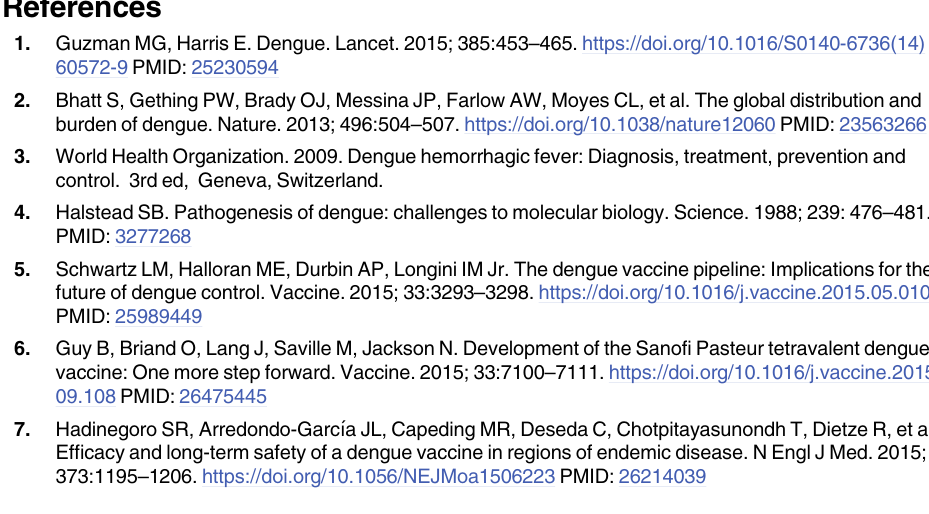
S3 Table. Age distribution of dengue and severe dengue cases during the 2015 outbreak in Kaohsiung City and in Sanmin and Nanzih districts. S4 Table. DENV IgG positivity and underlying chronic diseases among those < 60